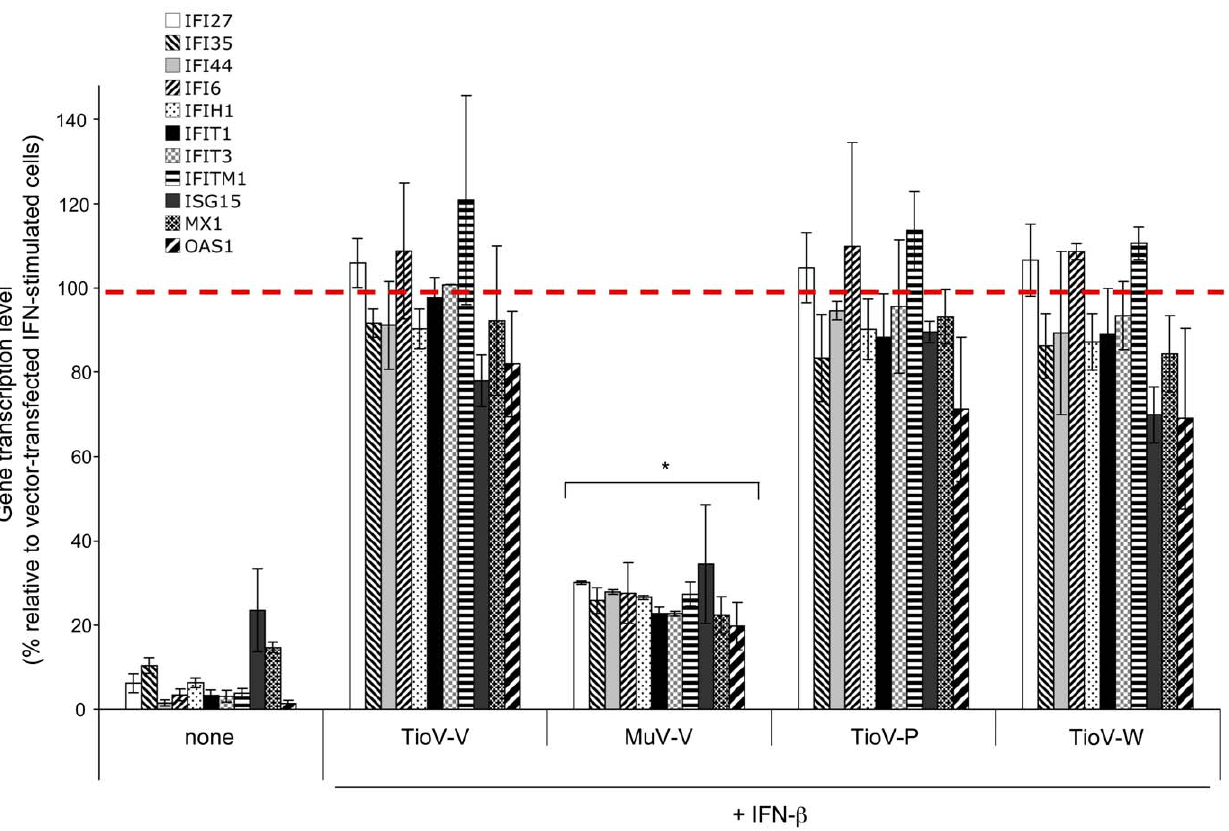
Figure 4. Expression of IFN-inducible genes is impaired by MuV-V but not TioV-V expression. HEK-293T cells were transfected with pCI- neo-3xFLAG expression vectors encoding for 3xFLAG alone or fused to TioV-V, MuV-V, TioV-P or TioV-W (500 ng/well). 24 h after transfection, cells were left unstimulated or stimulated with 200 IU/ml of recombinant IFN- b . After 24 h of culture, total RNAs were extracted, and expression levels of indicated genes were quantified by qRT-PCR. For each gene, data were normalized so that 100% corresponds to cells transfected with pCI-neo- 3xFLAG empty vector and stimulated with recombinant IFN- b (dotted red line). Experiment was performed twice and data represent means 6 SD. *indicates that differences observed with MuV-V relative to controls cells transfected with 3xFLAG alone and stimulated with IFN- b were statistically significant (p-value , 0.05).